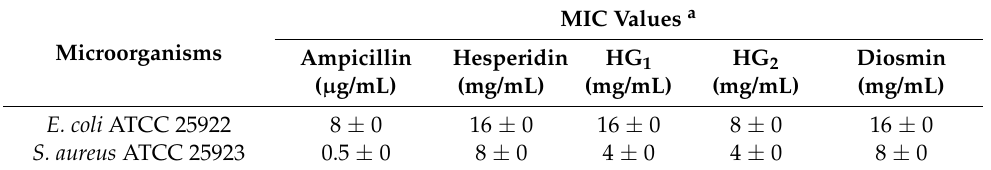
Figure 5. Structure of the HG products: ( A ) HG 1 and ( B ) HG 2 . *, the carbon positions of first added glucose (C-glucose II, Table 1) and **, the carbon positions of second added glucose (C-glucose III, Table 1). Table 1. 13 C-NMR analysis of hesperetin, hesperidin and HG products. Table 2. Minimal inhibitory concentration (MIC) of hesperidin glycosides, diosmin, and standard drug. Carbon Atom Microorganisms